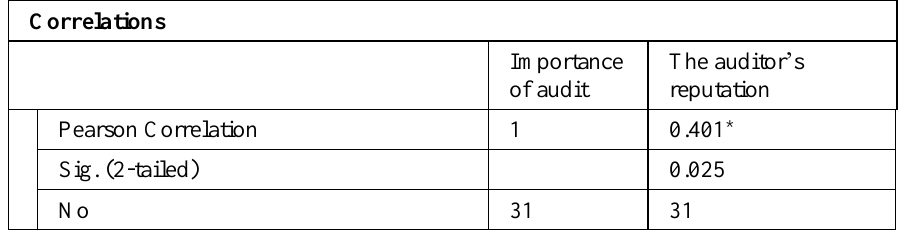
Table 9. The relationship between the importance of the auditing and auditor’s reputation [Table and calculations made by